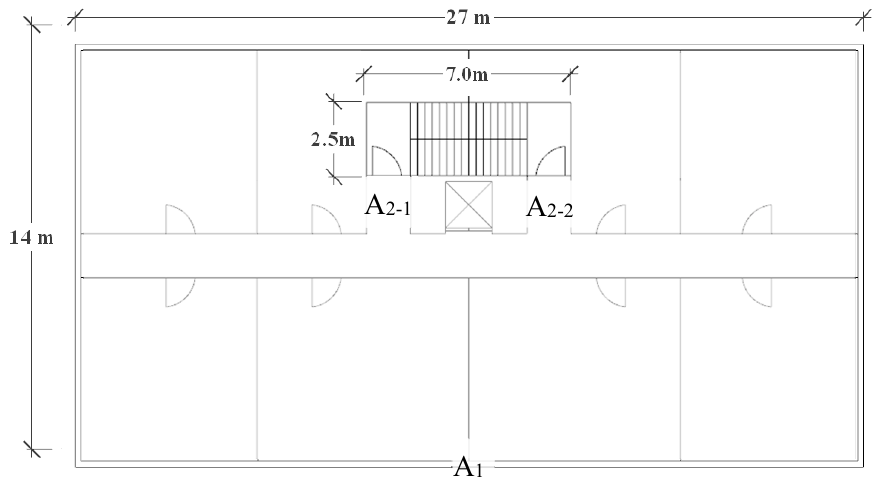
Figure 7. Plan of 10 story MURB used in smoke spread simulation showing idealized paths of leakage. The outline of corridors and other separators can be seen but are not part of simulations.